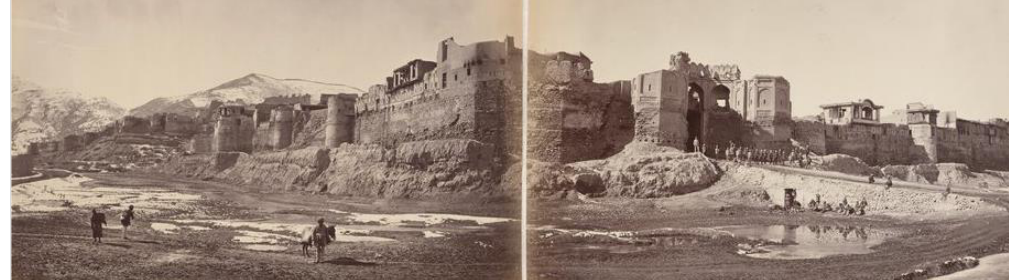
Figure 4 photograph showing Bala Hissar fort view in kabul city (Woodburn,